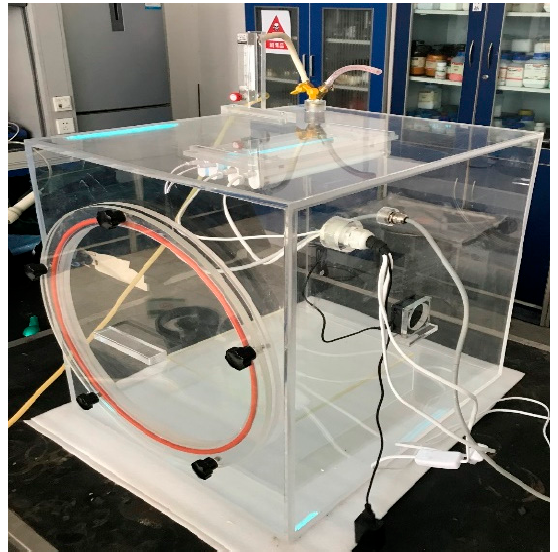
Figure 1. The photocatalytic vehicle exhaust (VE) reaction chamber.